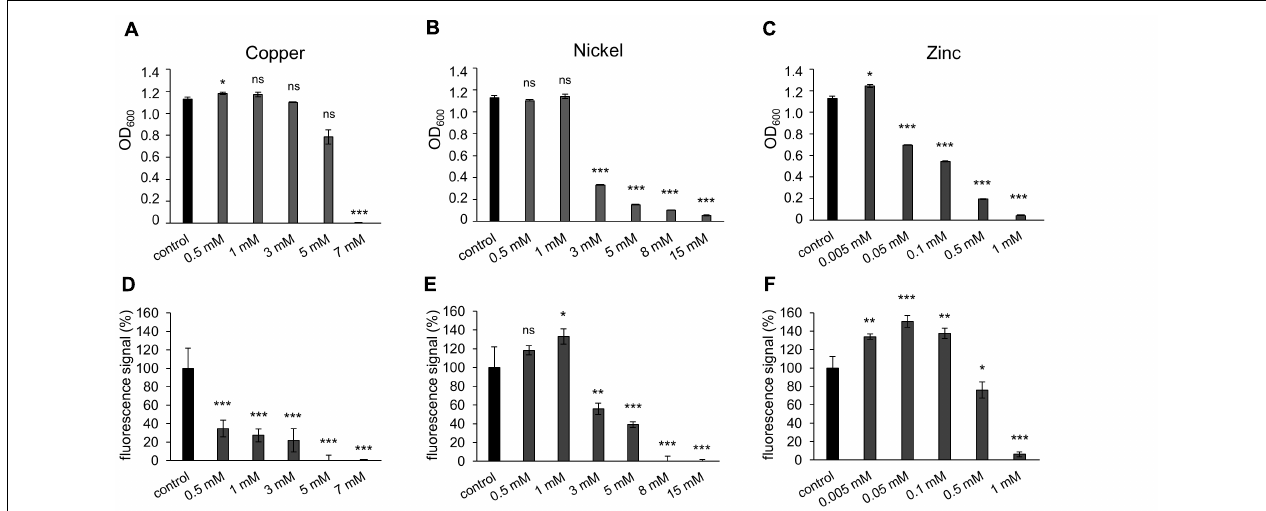
FIGURE 1 | Effect of metal ions copper, nickel and zinc on planktonic growth and adhesion of Halobacterium salinarum R1. (A–C) Optical density of planktonic cultures of H. salinarum after growth in complex medium containing copper, nickel or zinc. Control, cultivation in complex medium. Diagrams show the final optical density at 600 nm (OD 600 ) after 72 h cultivation. Data based on three independent cultures. (D–F) Fluorescence-based adhesion assay of H. salinarum after 13 days cultivation in complex medium containing copper, nickel or zinc ions. Control, cultivation in complex medium. Diagrams show the relative adhesion of the metal-treated cells in relation to untreated cells (set to 100%). Data based on four independent experiments. The significance of the results obtained with metal-treated samples compared to the control was assessed by t -test (ns, not significant, ∗ significant = P < 0.05, ∗∗ highly significant = P < 0.01, ∗∗∗ extremely significant = P <